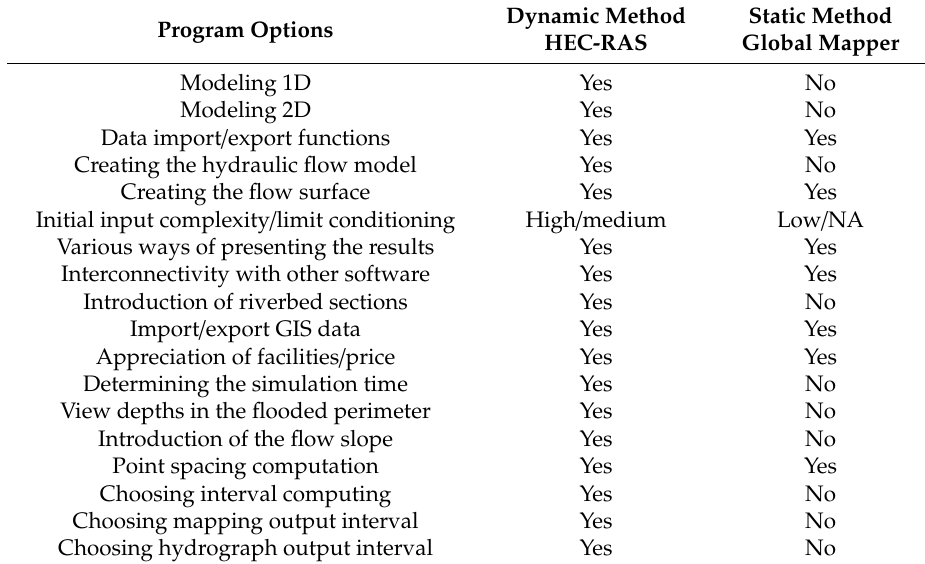
Table 6. Comparative analysis of the analysis methods